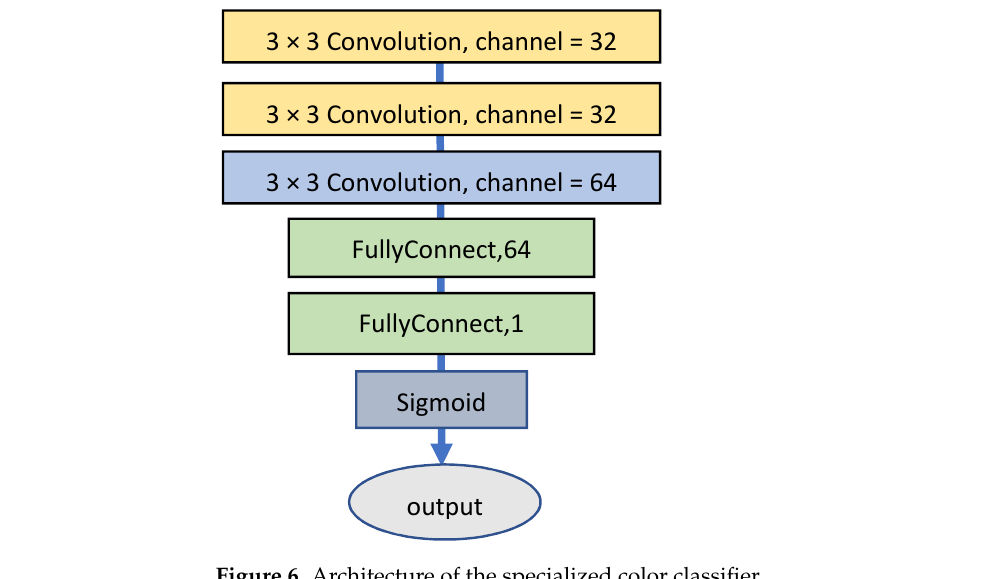
Figure 6. Architecture of the specialized color classifier.